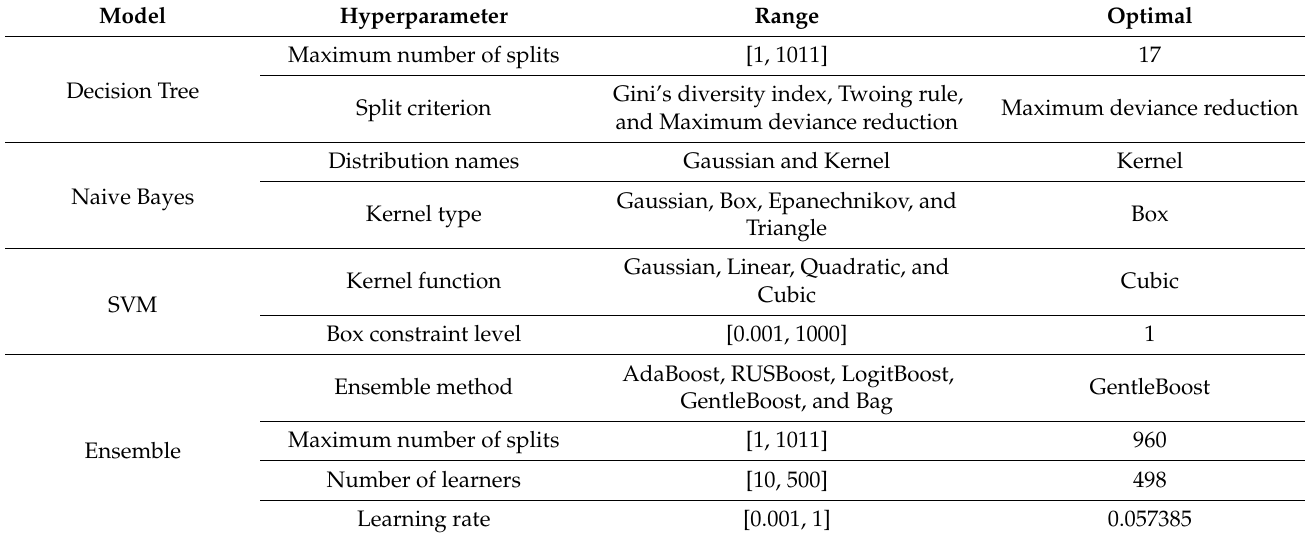
Table 5. Hyperparameters, search range, and selected optimal value.